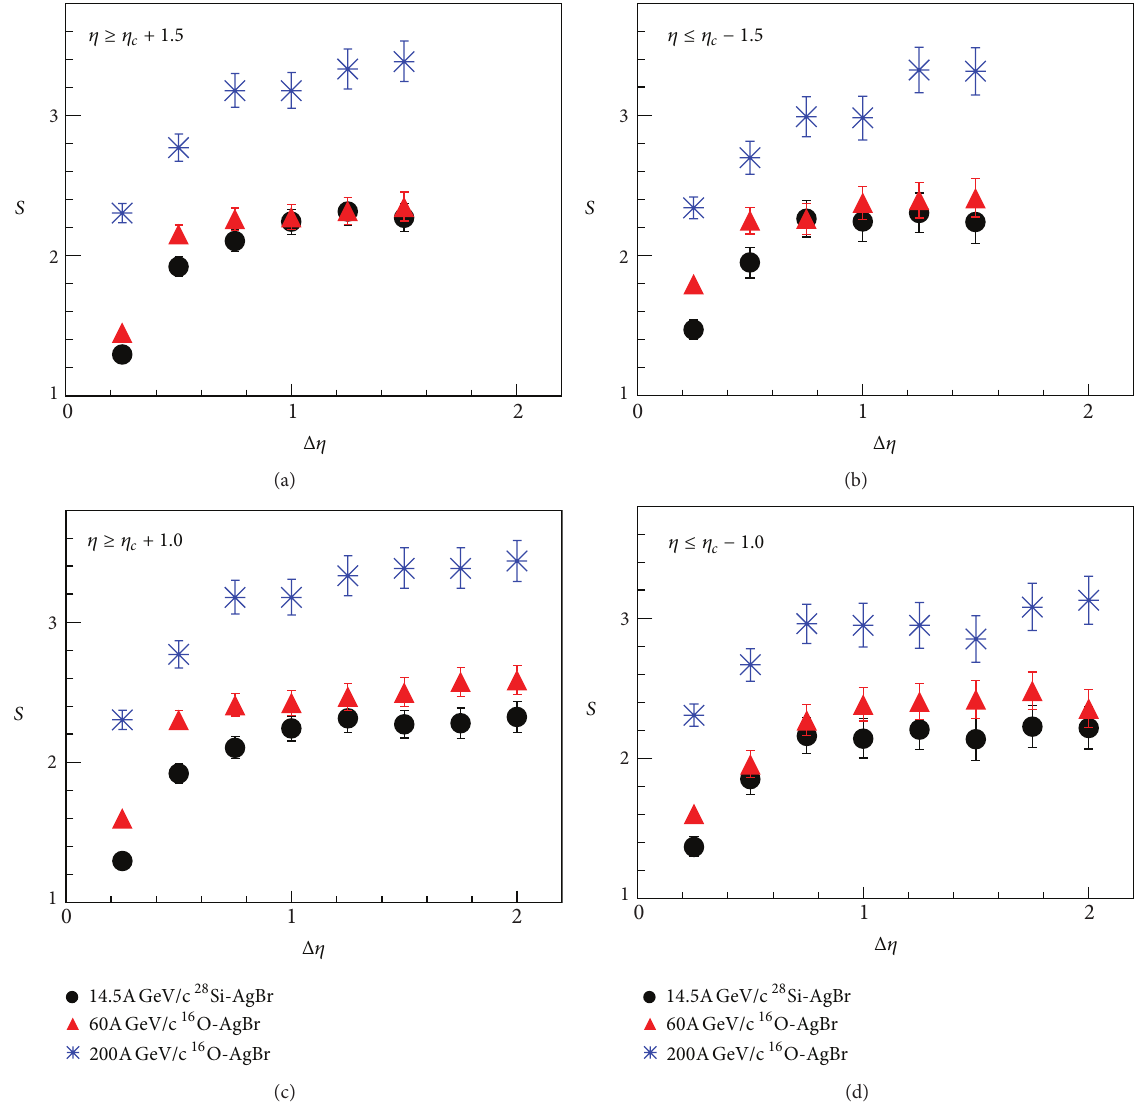
Figure 5: 𝑆 versus Δ𝜂 plots for the forward and backward regions separated by 𝜂 gaps of 3 units ((a), (b)) and 2 units ((c),